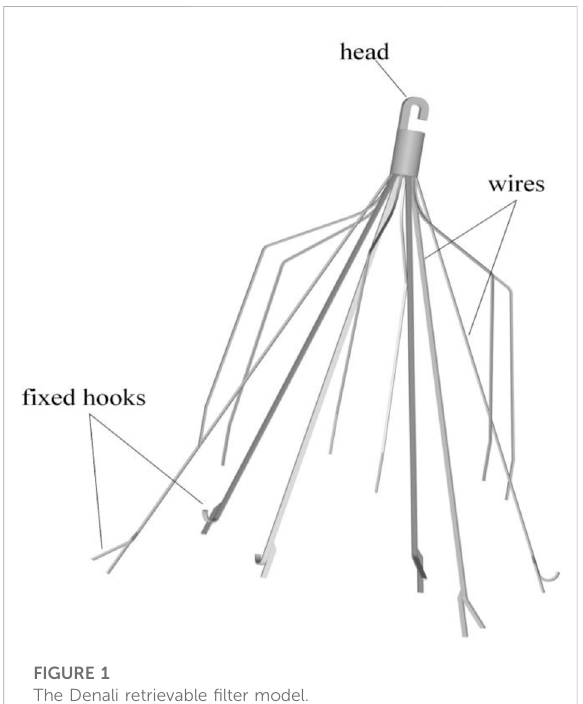
FIGURE 1 The Denali retrievable fi lter